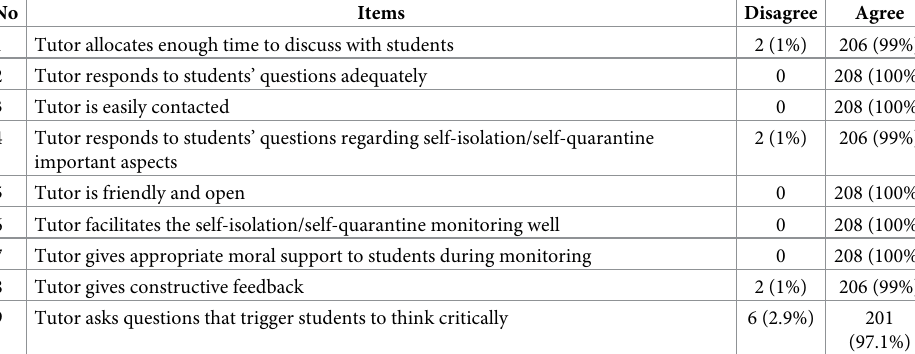
Table 5. Students’ satisfaction with tutors (N =